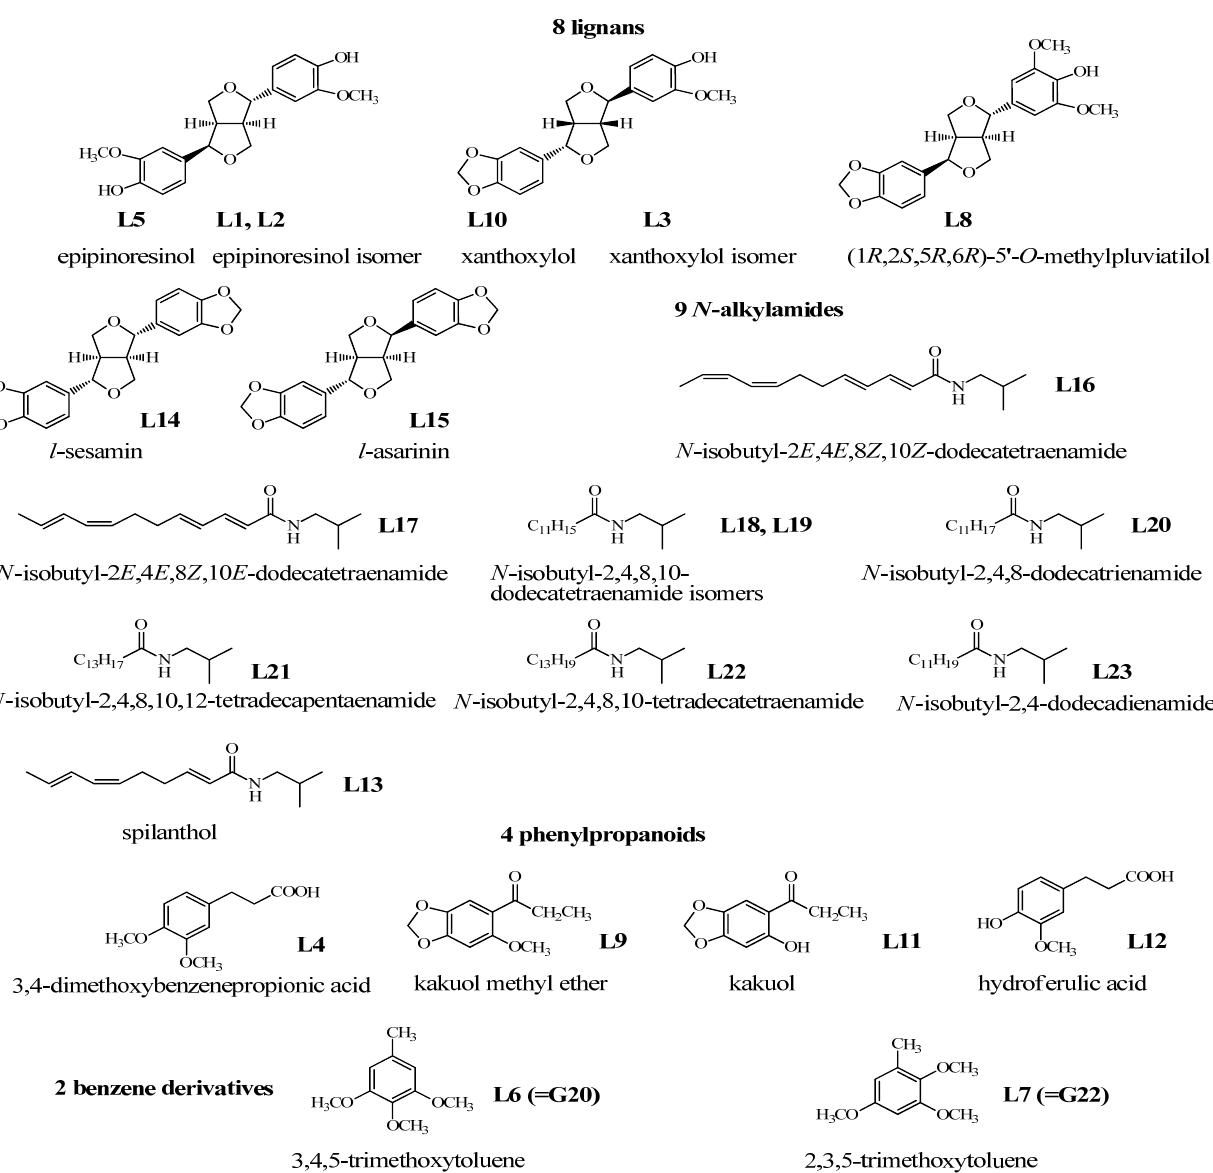
Figure 6. Chemical structures of 23 absorbed constituents identified in rabbit plasma from AR EtOAc extract group identified by HPLC-APCI-IT-TOF-MS n